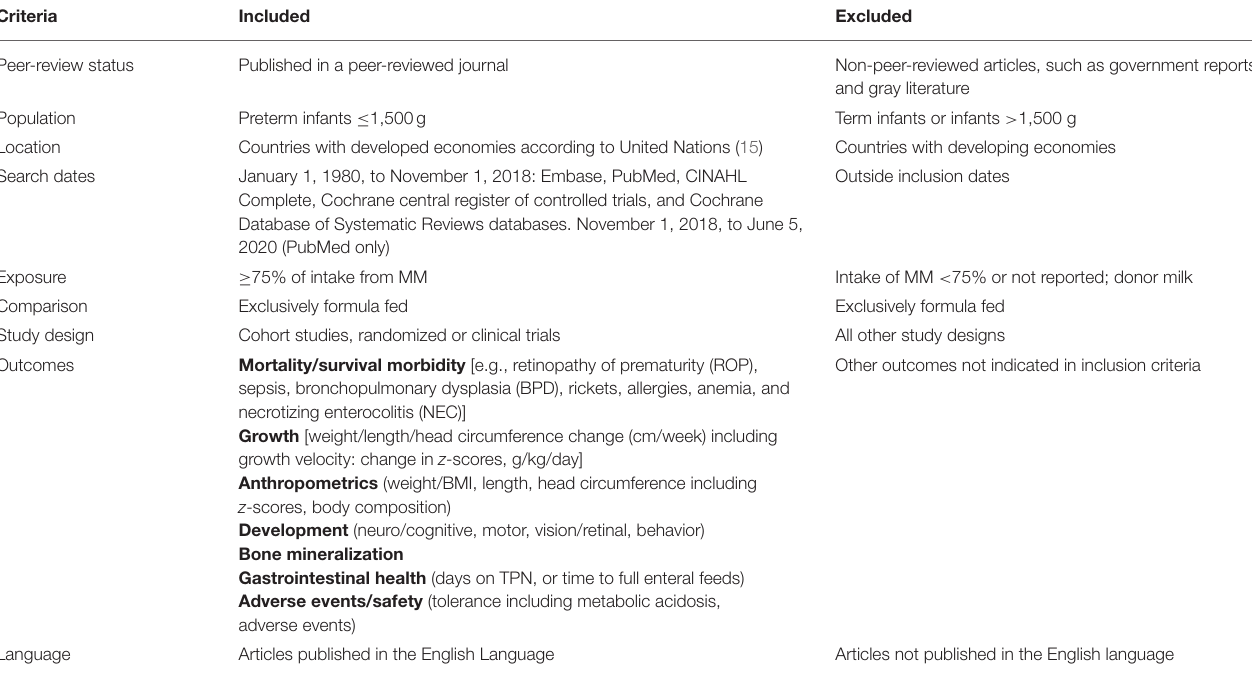
TABLE 1 | Inclusion criteria for the SR examining the association between MM intake and formula intake on growth and health outcomes in VLBW preterm